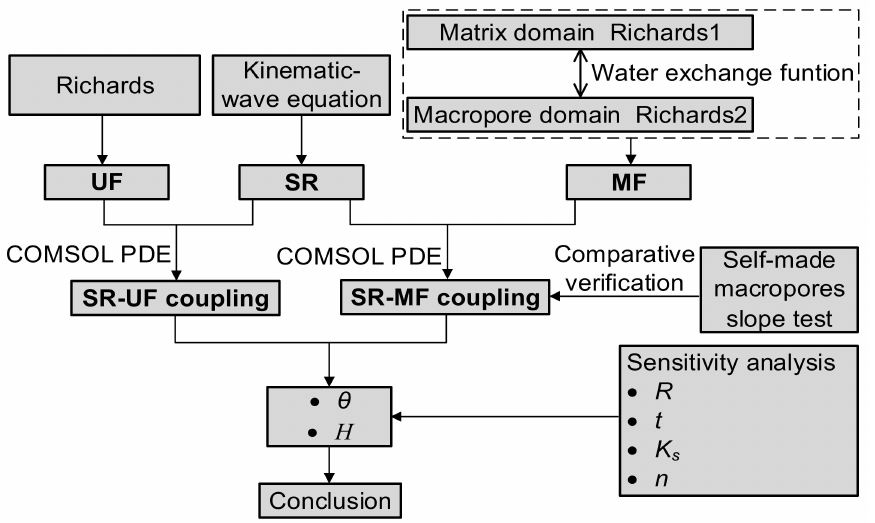
Figure 1. Research framework. ( θ —Water content; H —Ponding depth; R —Rainfall intensity; t — Rainfall duration; K s —Saturated conductivity; n —Roughness